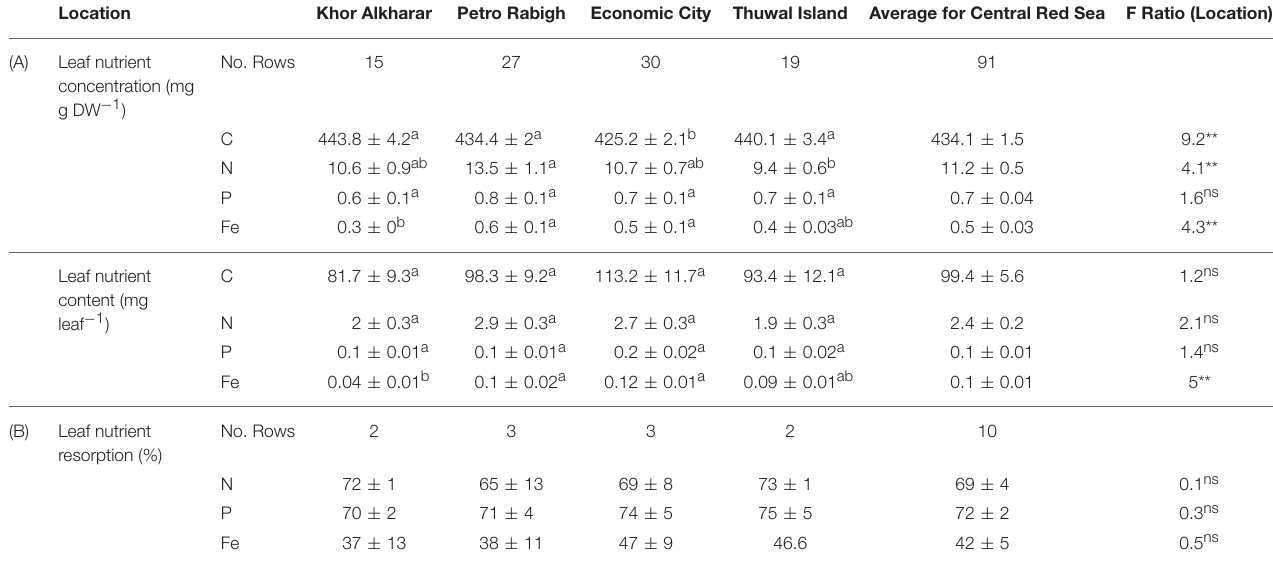
TABLE 2 | (A) Mean ( ± SE) for nutrients concentration (mg g DW − 1 ), nutrients content (mg leaf − 1 ) and (B) nutrients resorption (%) in Avicennia marina leaves from four different locations in the Central Red Sea, and the results (F-ratio) from ANOVA and Tukey HSD post hoc tests for differences in nutrient concentrations among locations.